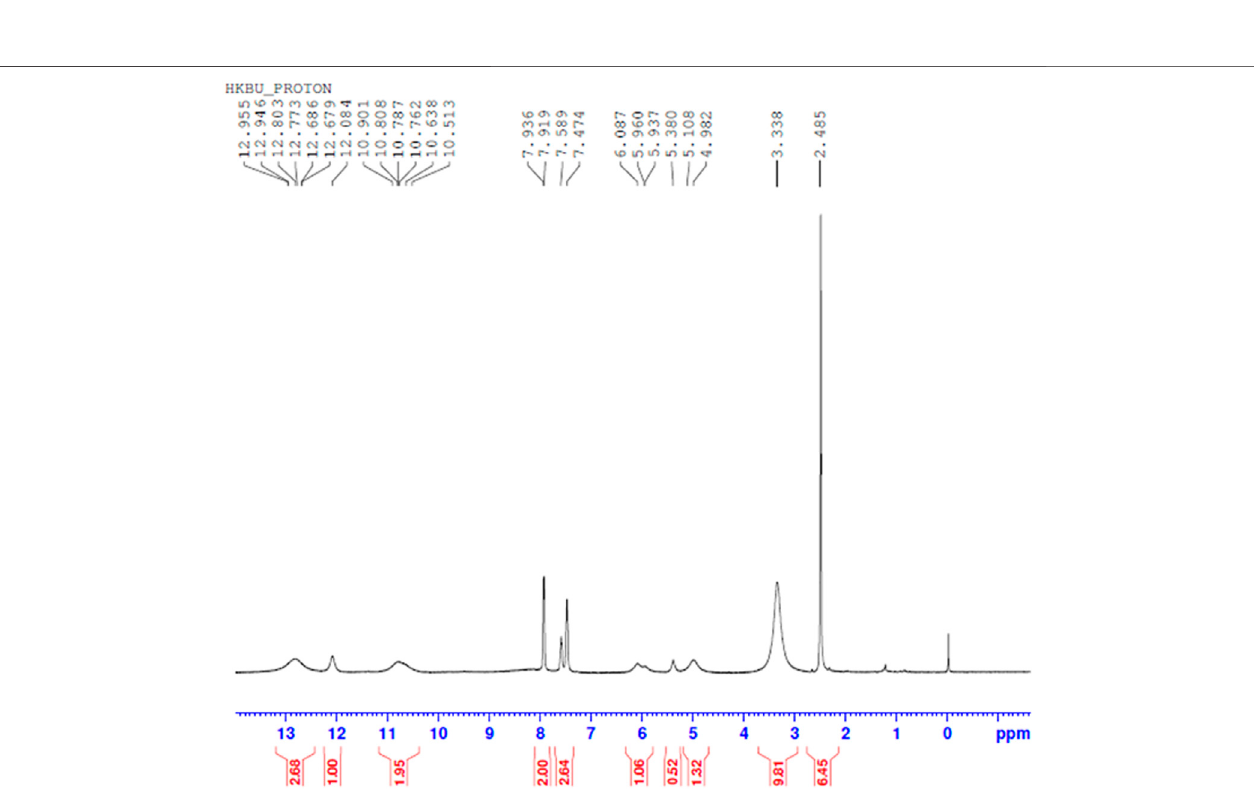
Frontiers in Chemistry |